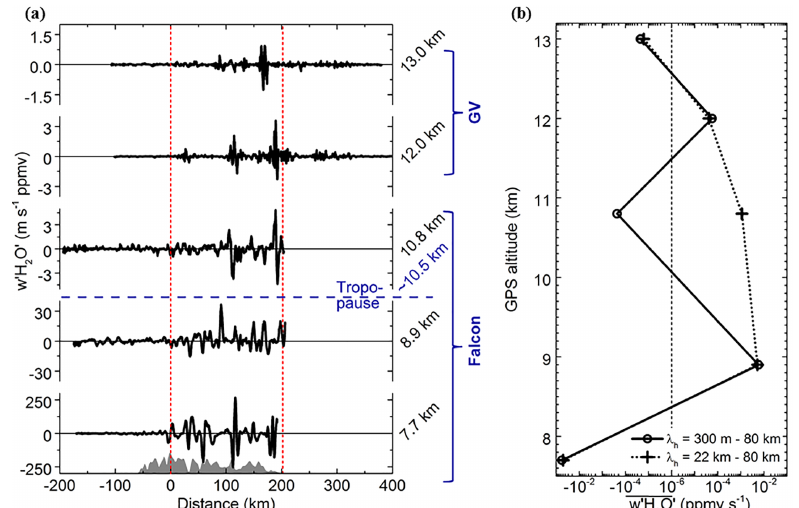
Figure 6. (a) Vertical water vapor fluxes using data from DLR Falcon flight FF05 (lower three panels) and NSF/NCAR GV flight RF16 (upper two panels) on 4 July 2014. The fluxes are shown for different flight altitudes over the topography of the Southern Alps. The approximate height of the tropopause at 10.5km is displayed by the dashed blue line. The red dashed lines mark the region that is used to get the water vapor fluxes shown in panel (b) . (b) Vertical profile of the water vapor fluxes integrated over the mountain region with the highest mountain wave activity. The profiles are shown for horizontal wavelengths between 300m and 80km (solid line) and between 22 and 80km (dashed